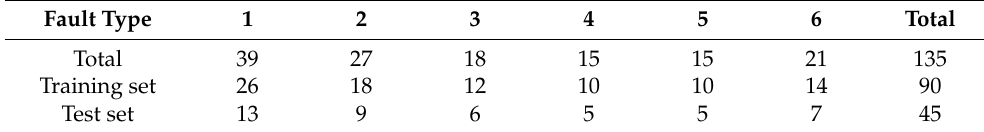
Table 6. Fault classification number.